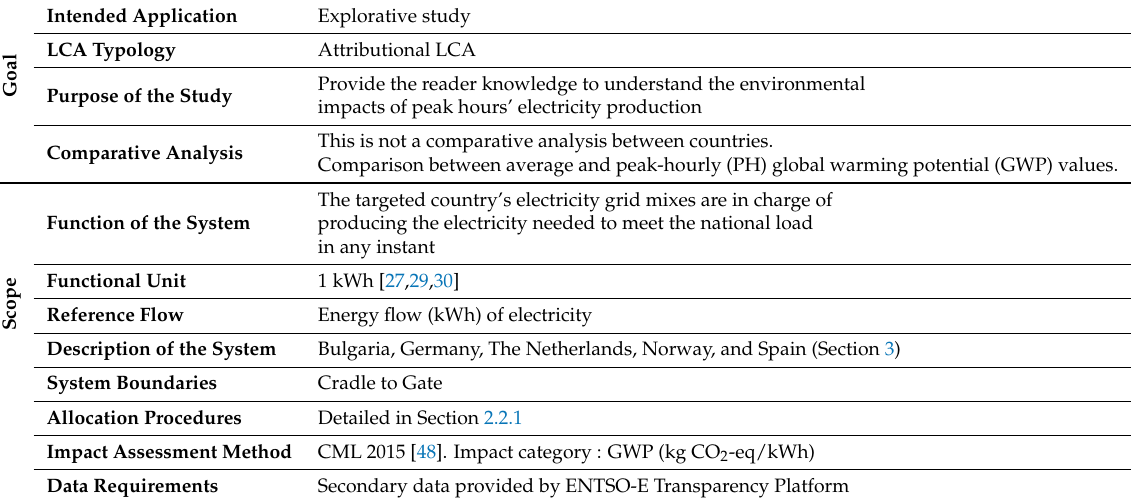
Table 1. Electricity grid mix LCA goal and scope